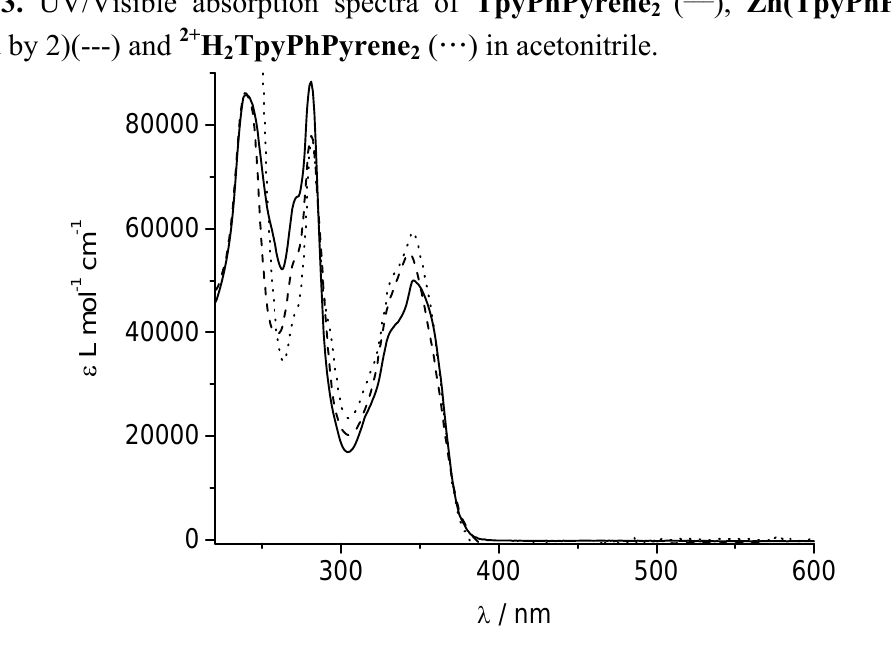
( ___ ), Zn(TpyPhPyrene 2